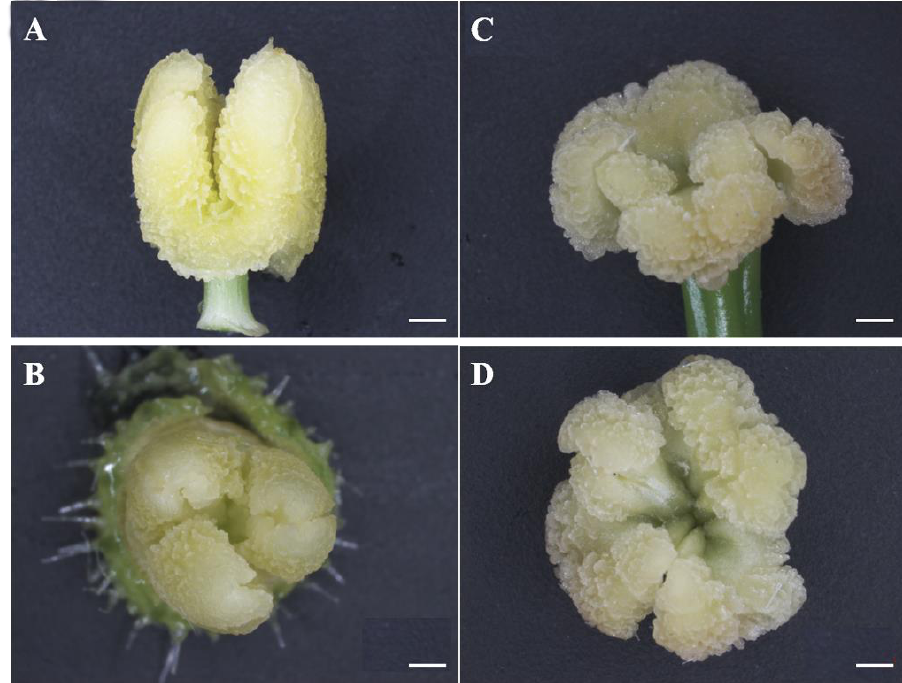
Figure 9. Anatomical observations of stigma of odd1 . ( A , B ) The stigma of WT at anthesis. ( C , D ) The stigma of odd1 at anthesis. Scale bars represent 5 mm.